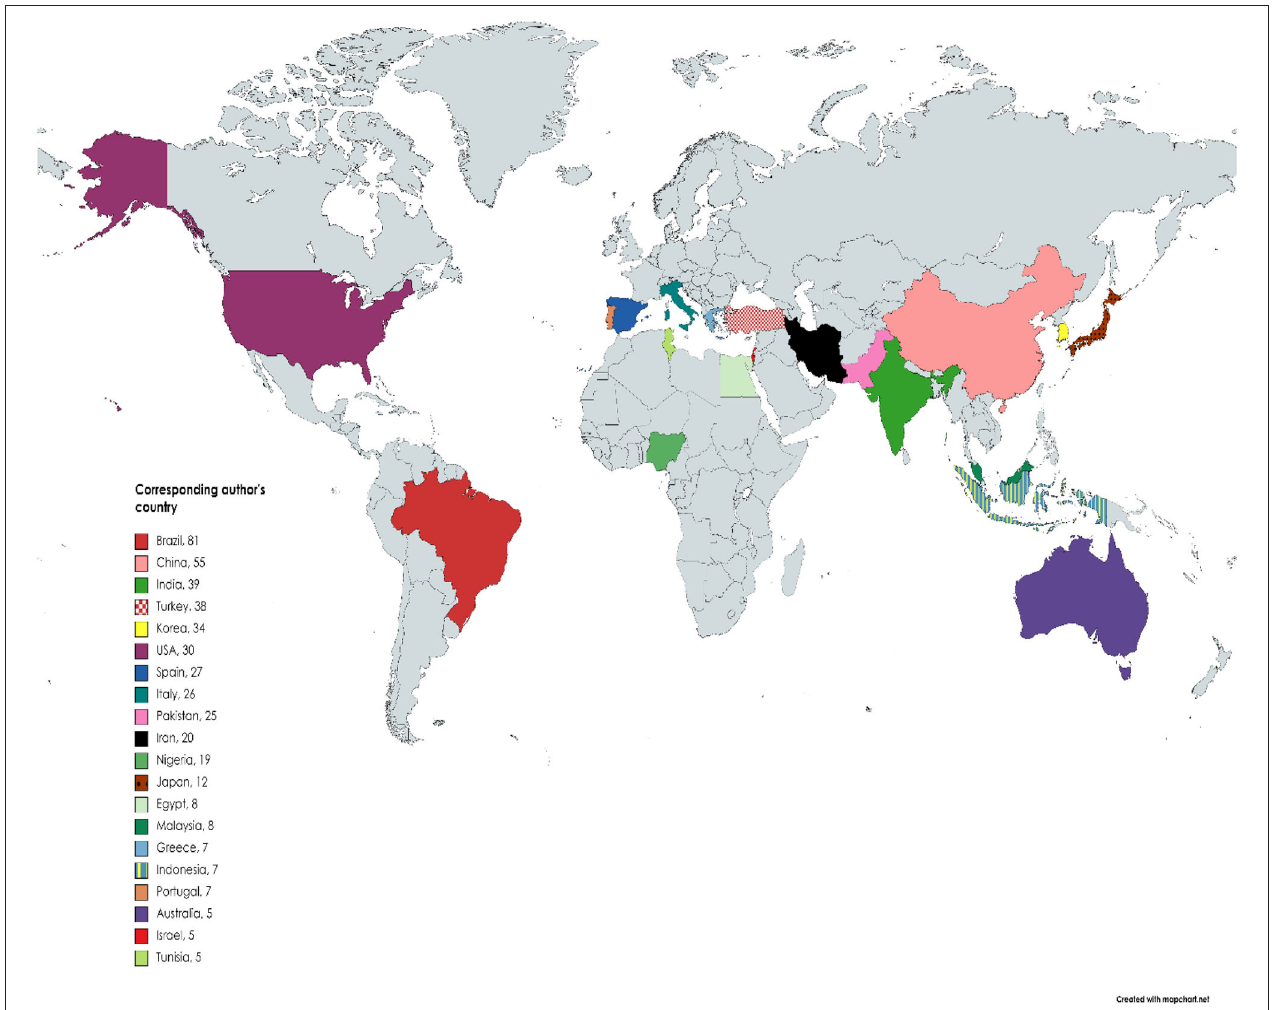
FIGURE 2 | Spatial mapping of the top 20 most productive nations based on number of research articles on citrus waste and animal feed studies (Corresponding author’s countries). Gray color areas depict the zones that are not among the top 20 nations.